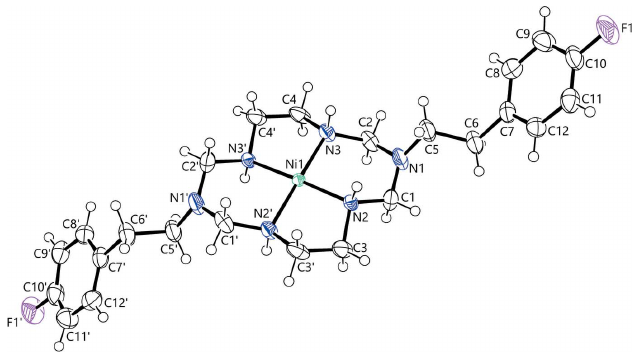
Figure 1 Molecular structure of one of the whole-molecule disorder component molecules of [Ni L ] 2+ with displacement ellipsoids at 50% probability level. The second disorder component, generated by (1 (cid:5) x , y , 1 omitted for